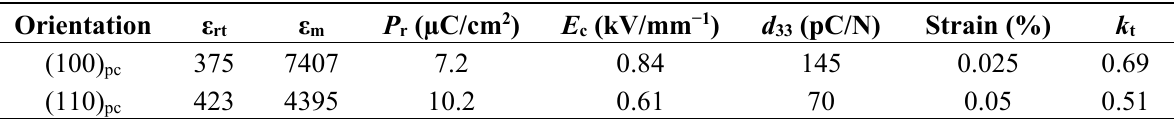
Table 2. Dielectric, piezoelectric and ferroelectric properties of (100) pc and (110) pc orientated KNN25/75 single crystals ( ε rt represents the dielectric constant at room temperature). Reprinted with permission from [28]. Copyright 2014 Royal Society of Chemistry.